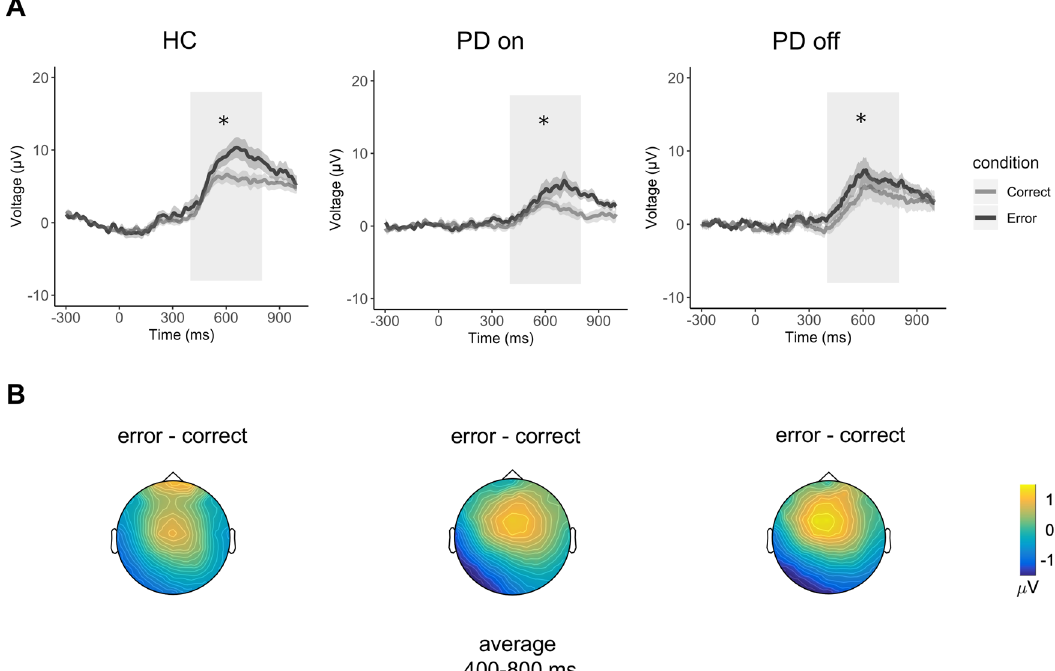
Fig. 2 Electrophysiological results in the time domain for each group (ERPs). A Grand average oPe waveforms at electrode Pz. The end of the avatar ’ s movement is at 0 ms. Lighter colours denote the standard error of the mean. The light grey rectangle demarks the analysis interval window. B Graphical representation of the voltage distribution. Values represent incorrect minus correct